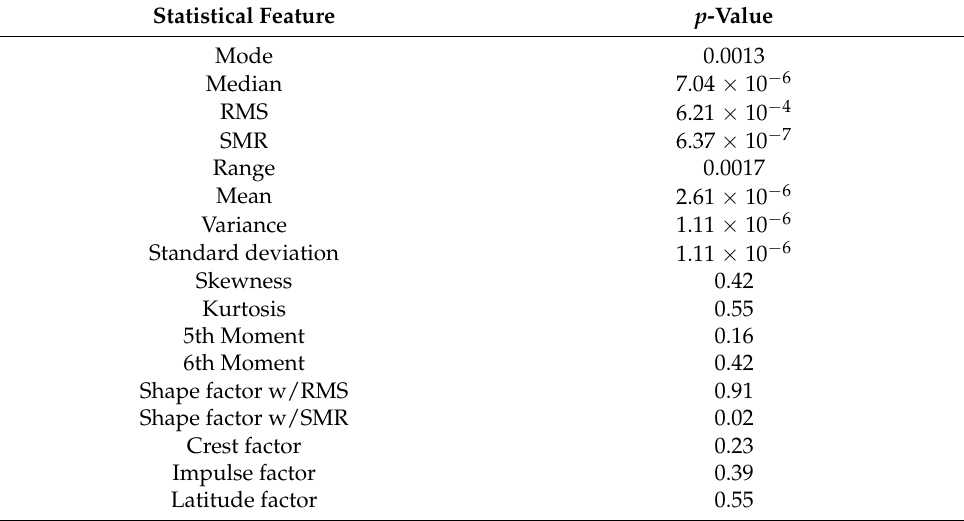
Table 3. p -values obtained using